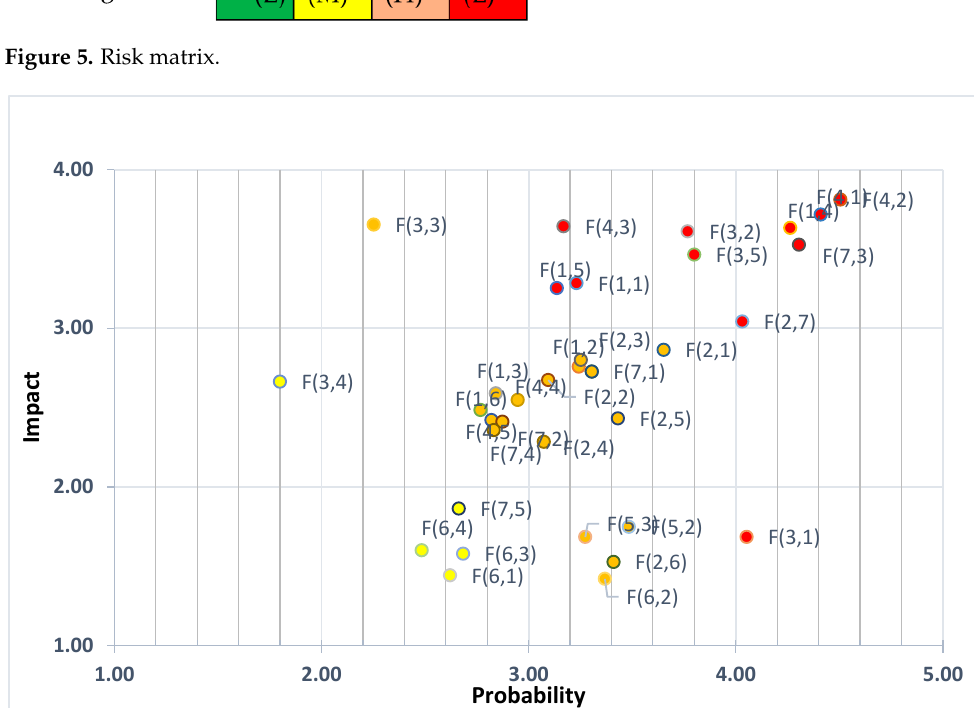
Figure 6. Risk matrix for the selected factors.